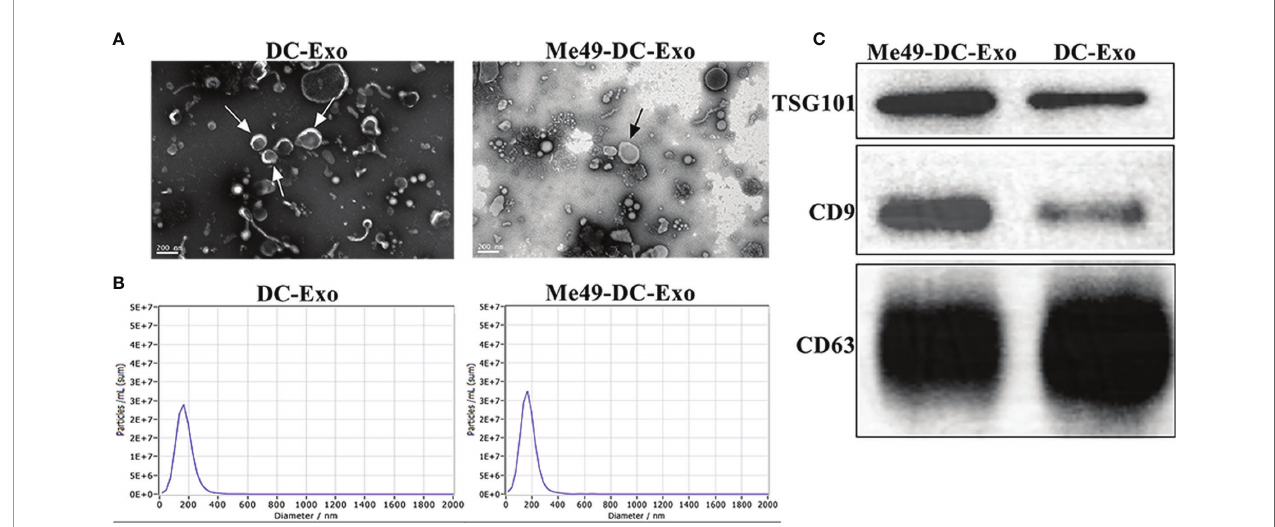
FIGURE 1 | Isolation and identi fi cation of exosomes. (A) Exosomes observed by TEM (80 KV, 30 K). (B) Size and distribution of exosomes analyzed by NTA. (C) Speci fi c markers of exosomes identi fi ed by